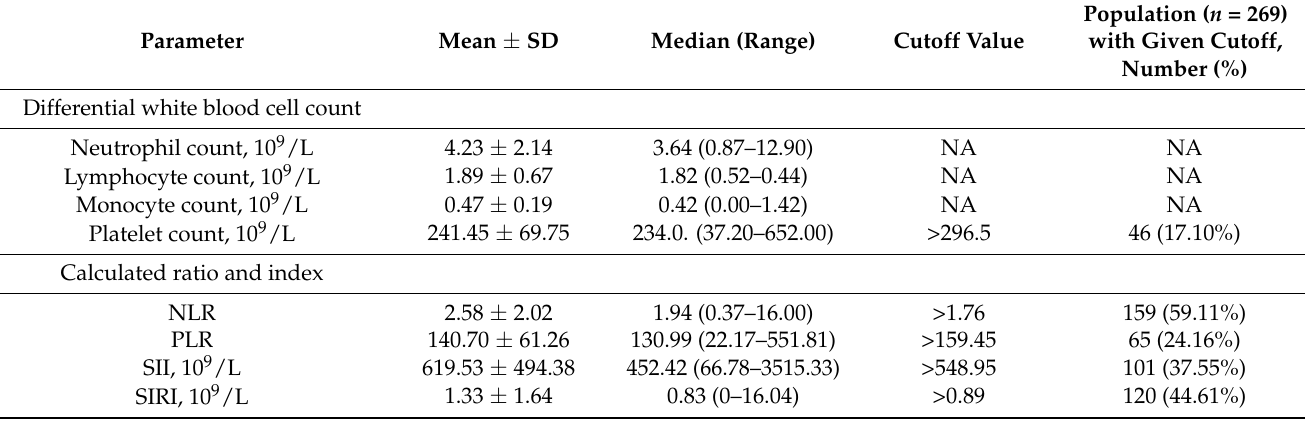
Table 3. Summary statistics of inflammatory markers in patients with oral squamous cell carcinoma.